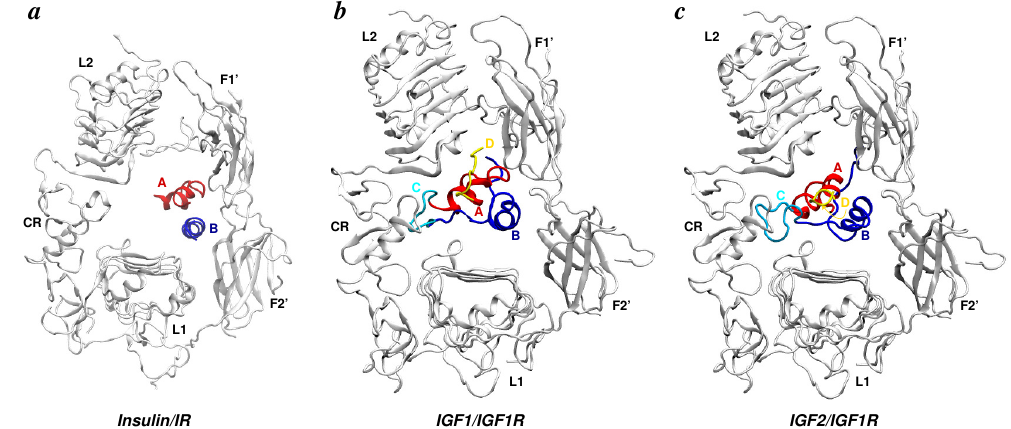
Docked conformations of insulin and IGFs. Docked views of each ligand in the relatively open binding pocket (formed by the L1-CR-L2 motif of one subunit and